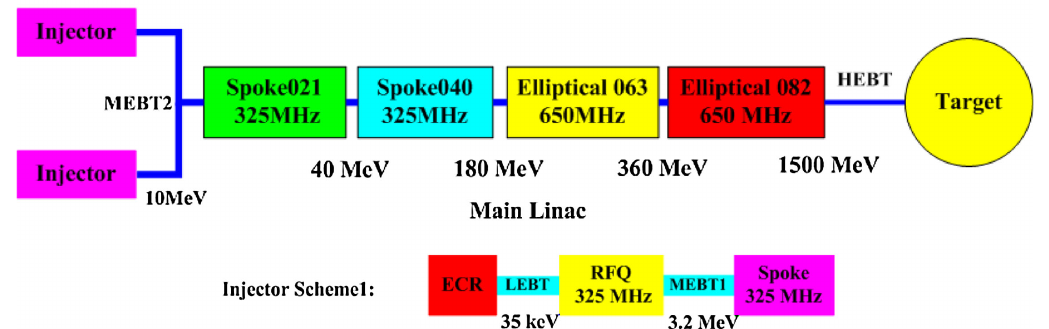
FIG. 3. Layout of the C-ADS driver